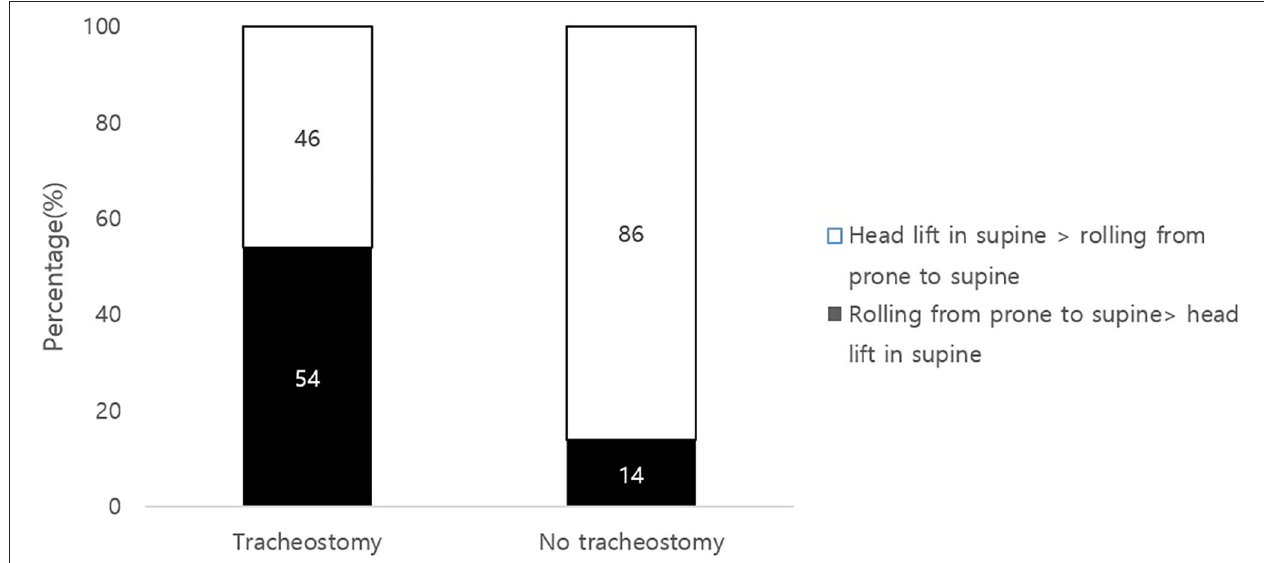
FIGURE 2 | Comparisons of head control and rolling scores in the tracheostmy to non-tracheostomy group. Scores of GMFM item of head lift in supine position and score of rolling from prone to supine position were compared. Note that 54% of the tracheostomy group scored better in rolling than a head control (black). Head control precedes rolling in typical developmental